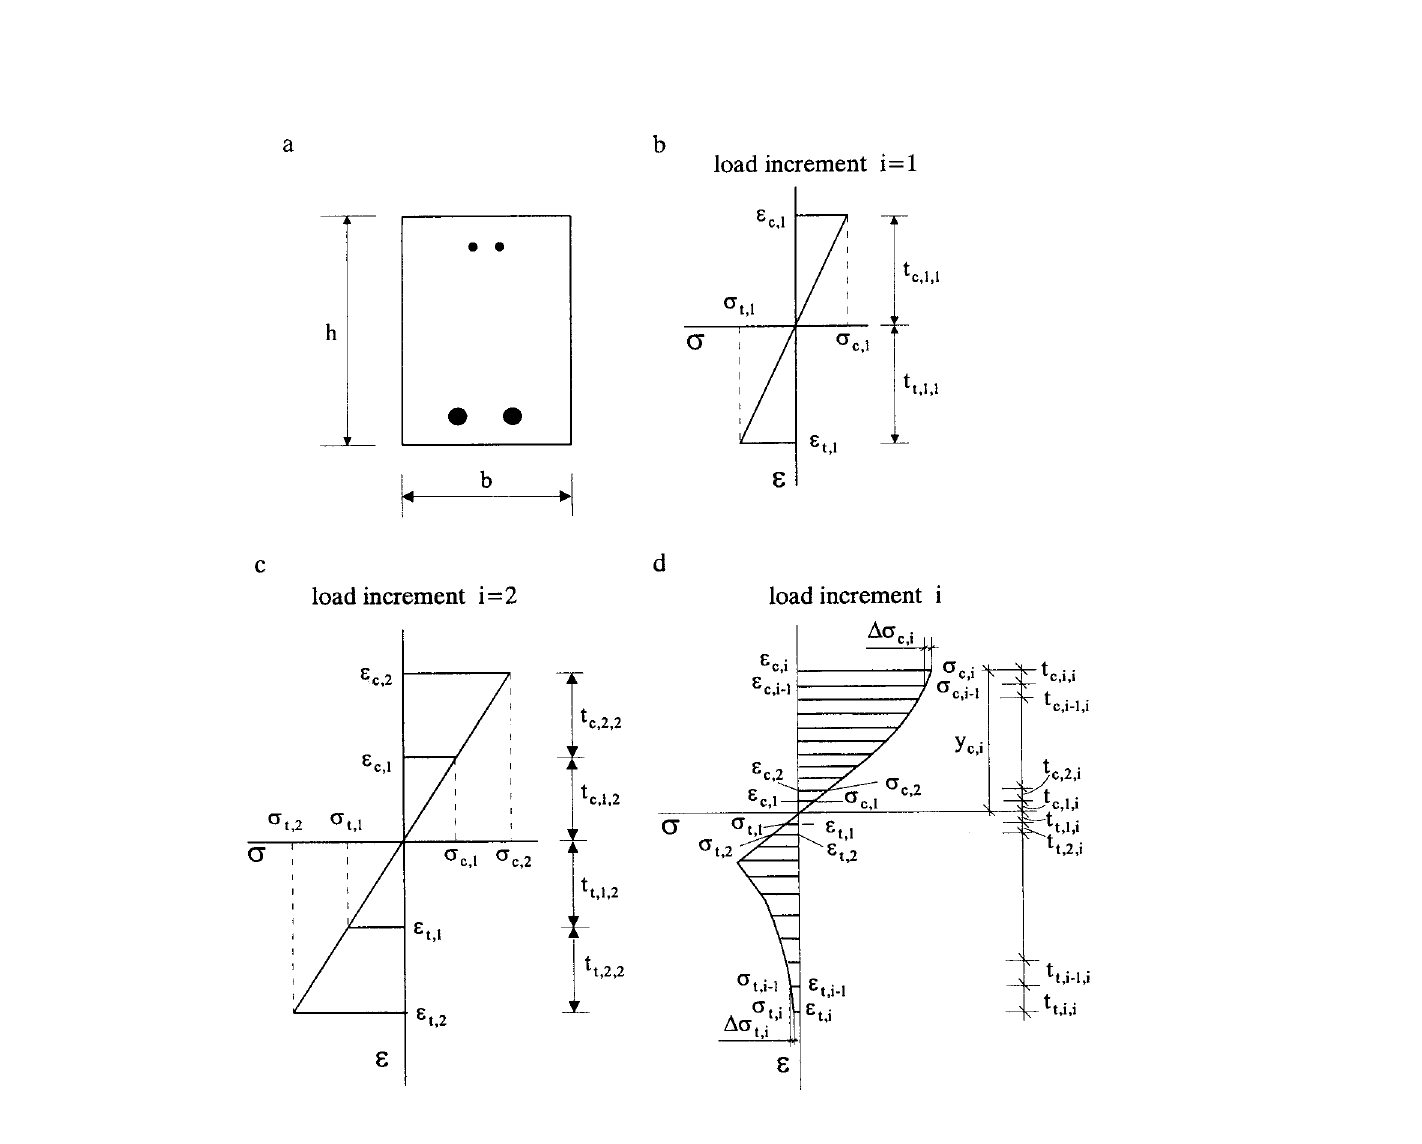
Fig 6. Stresses and strains and concrete layer assumption in a cross-section for different load stages (j = 1) since E c,1 , cr c,1 and E 1 ,1 and cr 1 ,1 are the same as for i = 1. The top fibre strains for the second The corresponding layers (j = 2) are E c,2 and E 1 ,2 . stresses cr c,2 and cr are computed from the two 1 ,2 equilibrium